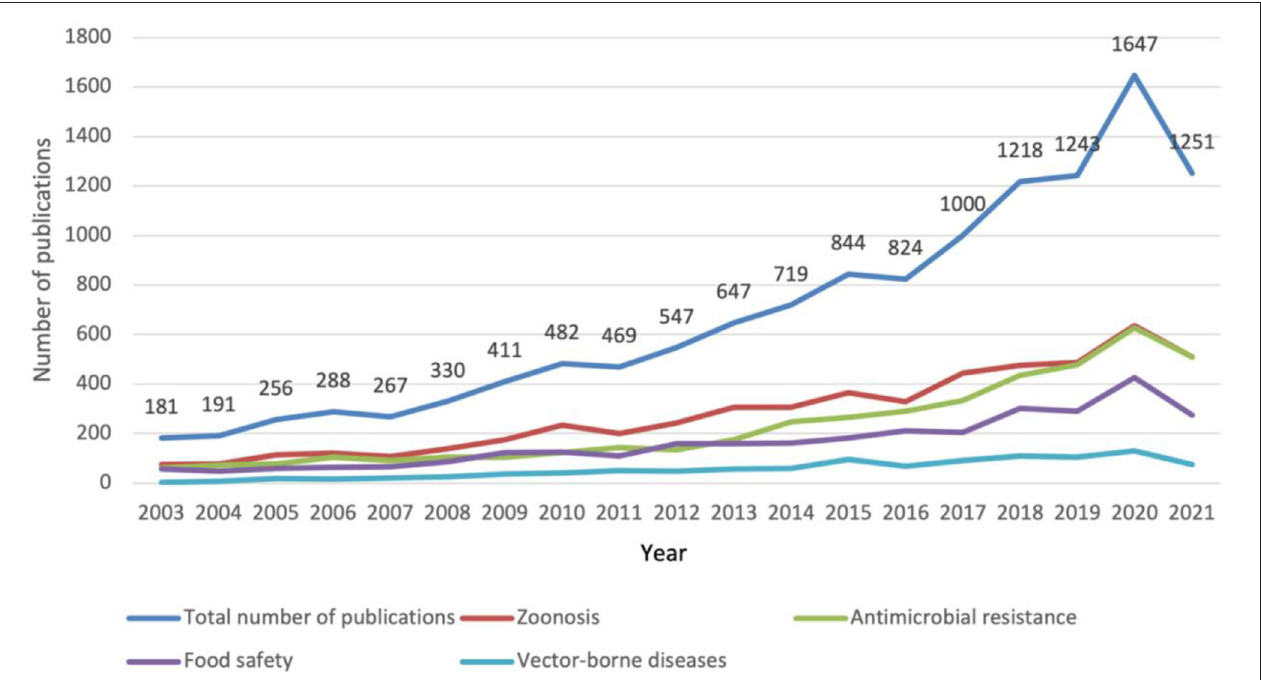
FIGURE 2 | Number of publications on the four priority topics of One Health, 2003–2021.